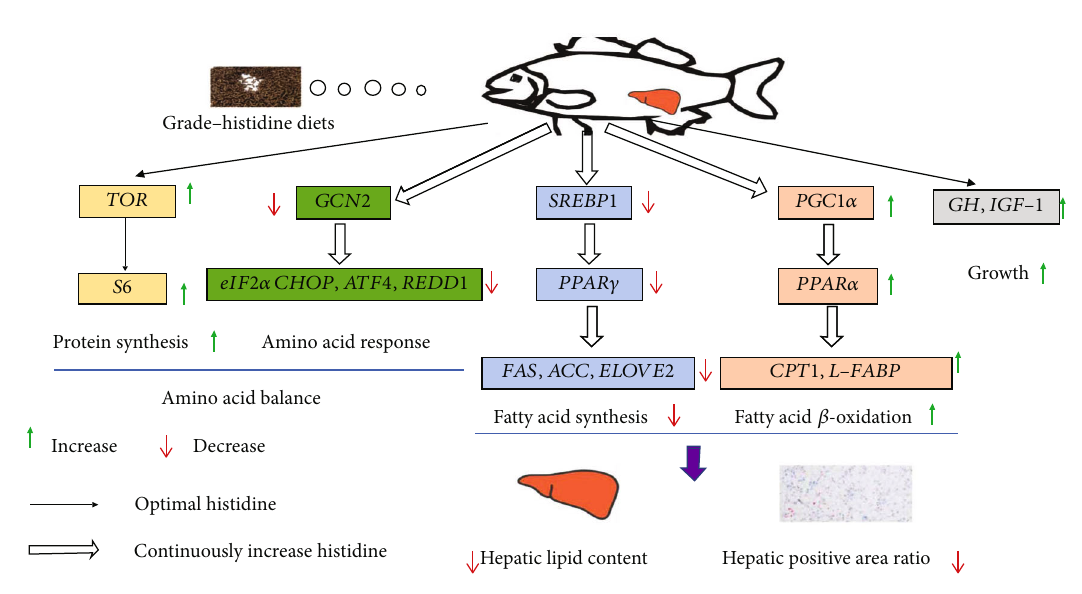
Figure 10: Scheme summarizing the nutrient metabolism in response to dietary histidine levels in juvenile largemouth